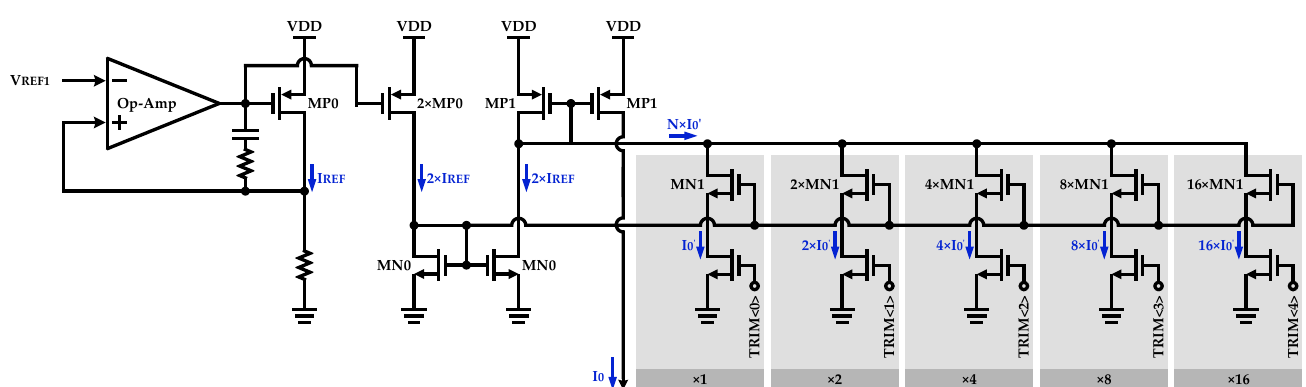
Figure 6. Schematic of the implemented programmable current source (Cur.Gen.1).